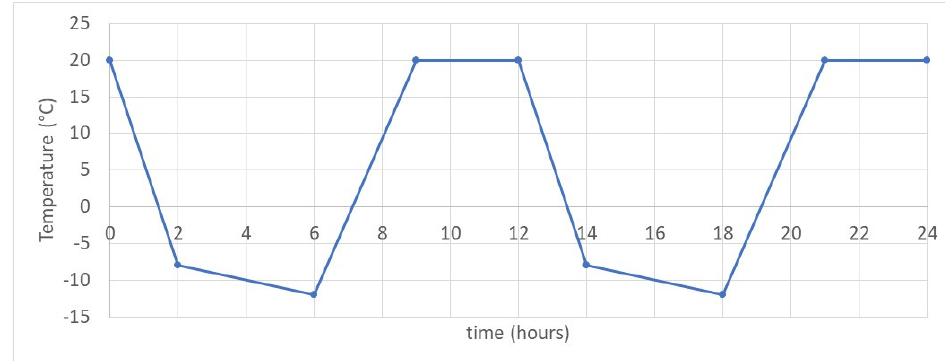
Figure 1. One day cycles of imposed temperature (2 cycles per day).